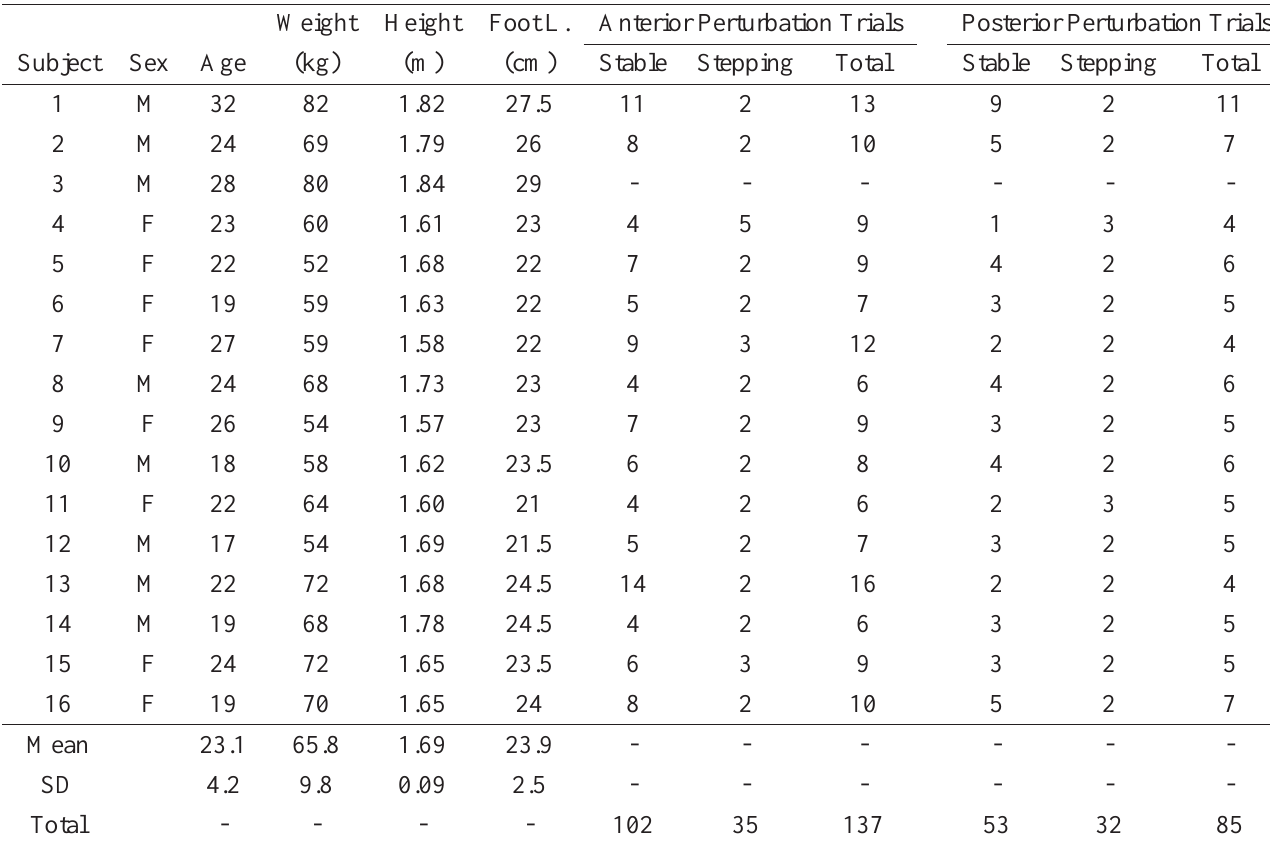
Table 1 . Demographic information of the subjects who participated in the study and perturbation trials completed